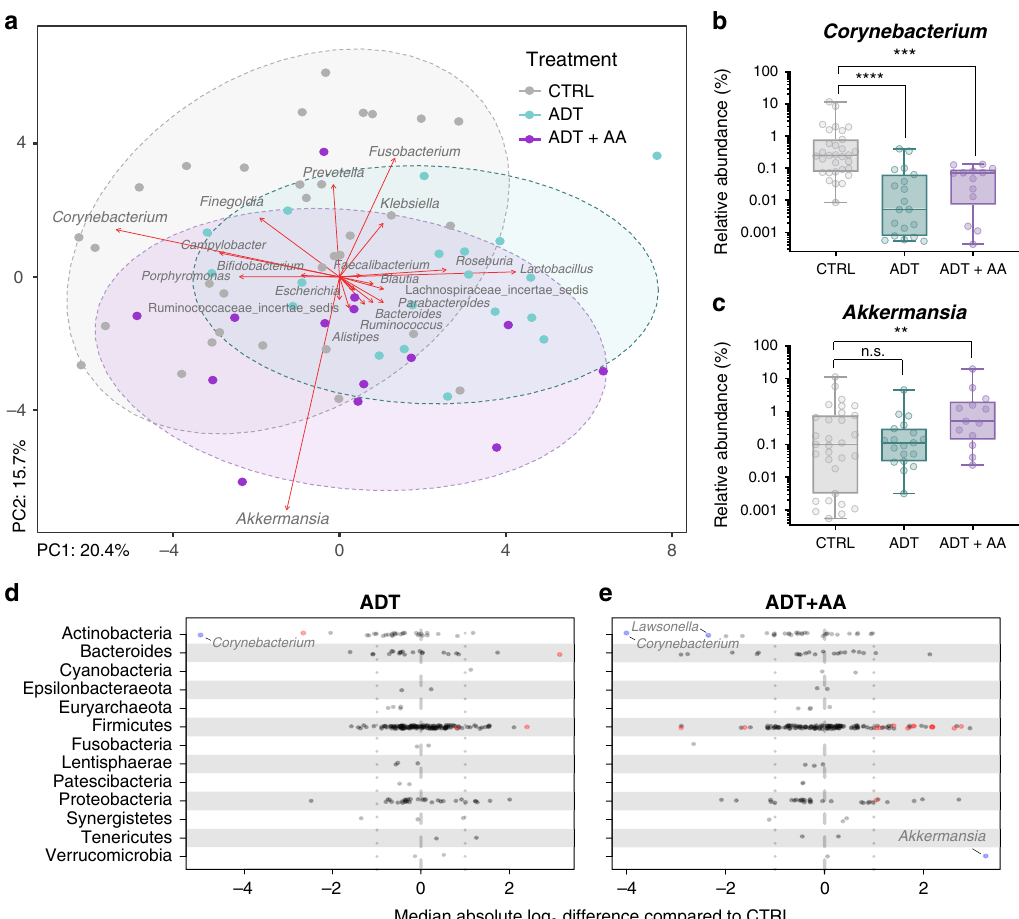
Fig. 1 Rectal swab microbiota from prostate cancer patients receiving no treatment CTRL, ADT, or ADT + AA. a Principal component analysis (PCA) plot of the microbiota from patient samples. Sequence variants were collapsed at genus-level identi fi cation, with clr-transformed Aitchison distances used as input values for PCA analysis. The distance between points represent differences in microbiota composition. Strength of association for taxa are depicted by the length of red arrows shown. Ellipses indicate 95% con fi dence intervals for each group. b , c Percent relative abundance of the two largest in fl uencers of microbiota separation based on treatment. Data represent the median (line in box), IQR (box), and minimum/maximum (whiskers) for CTRL ( n = 33), ADT ( n = 21), and ADT + AA ( n = 14) patient samples. Statistics shown are derived from multivariate analysis performed using MaAsLin2 additive generalized linear models with log 10 clr-transformed input values. d , e ALDEx2 strip charts showing differential abundances of taxa between different patient groups. Positive values indicate increased relative abundance, while negative values indicate decreased relative abundance in the speci fi ed treatment groups (ADT or ADT + AA) relative to the CTRL samples. Statistical analysis performed with ALDEx2 and MaAsLin2 software. Features are colored red if ALDEx2 effect size differences (>1) and MaAsLin2 p value (<0.05) thresholds are exceeded, and blue if effect size difference (>2) and p value (<0.05) thresholds are exceeded. ** P = 0.0030, *** p = 0.0007, **** p < 0.0001, and n.s. = not signi fi